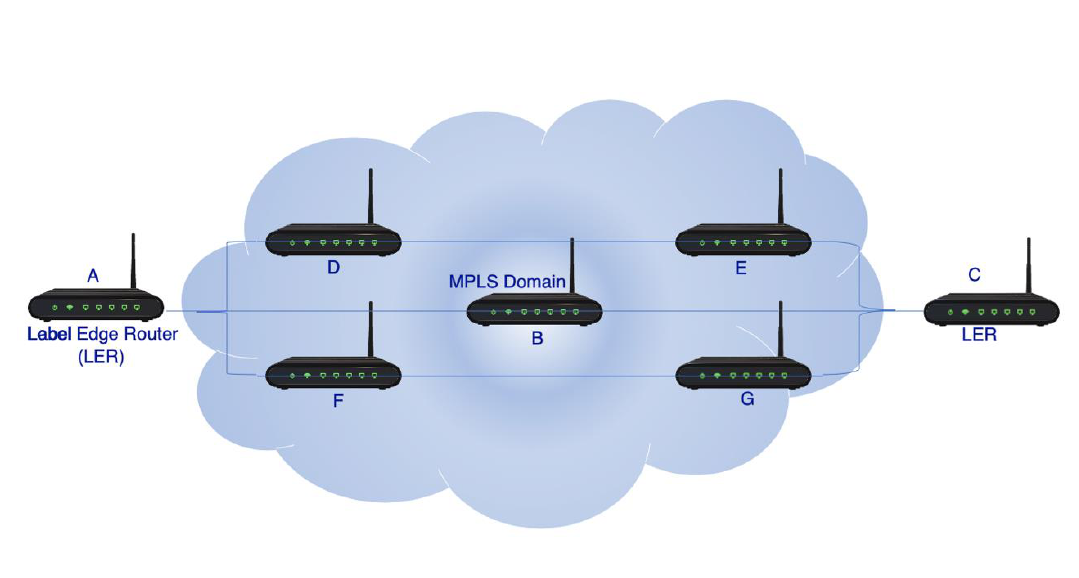
Figure 1. General Architecture of the MPLS